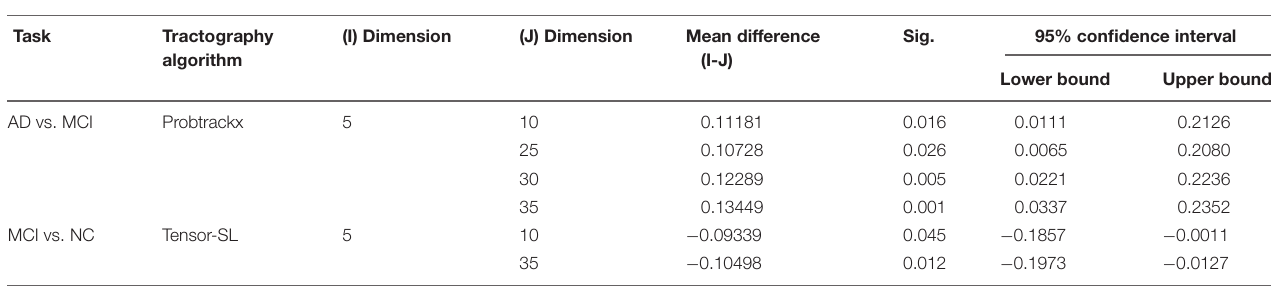
TABLE 7A | One-way ANOVA testing for differences in the classification performances across different GLRAM dimension parameters for nine tractography algorithms in three diagnostic tasks. Degrees of AD vs. NC AD vs. MCI MCI vs. NC freedom F Sig. F Sig. F Sig. 6 1.790